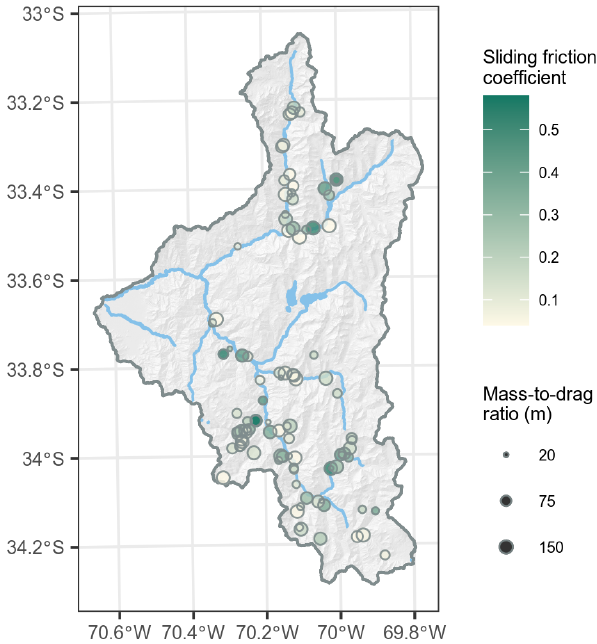
Figure 13. Map of runout-distance model optimal parameters de- termined for individual debris flows.